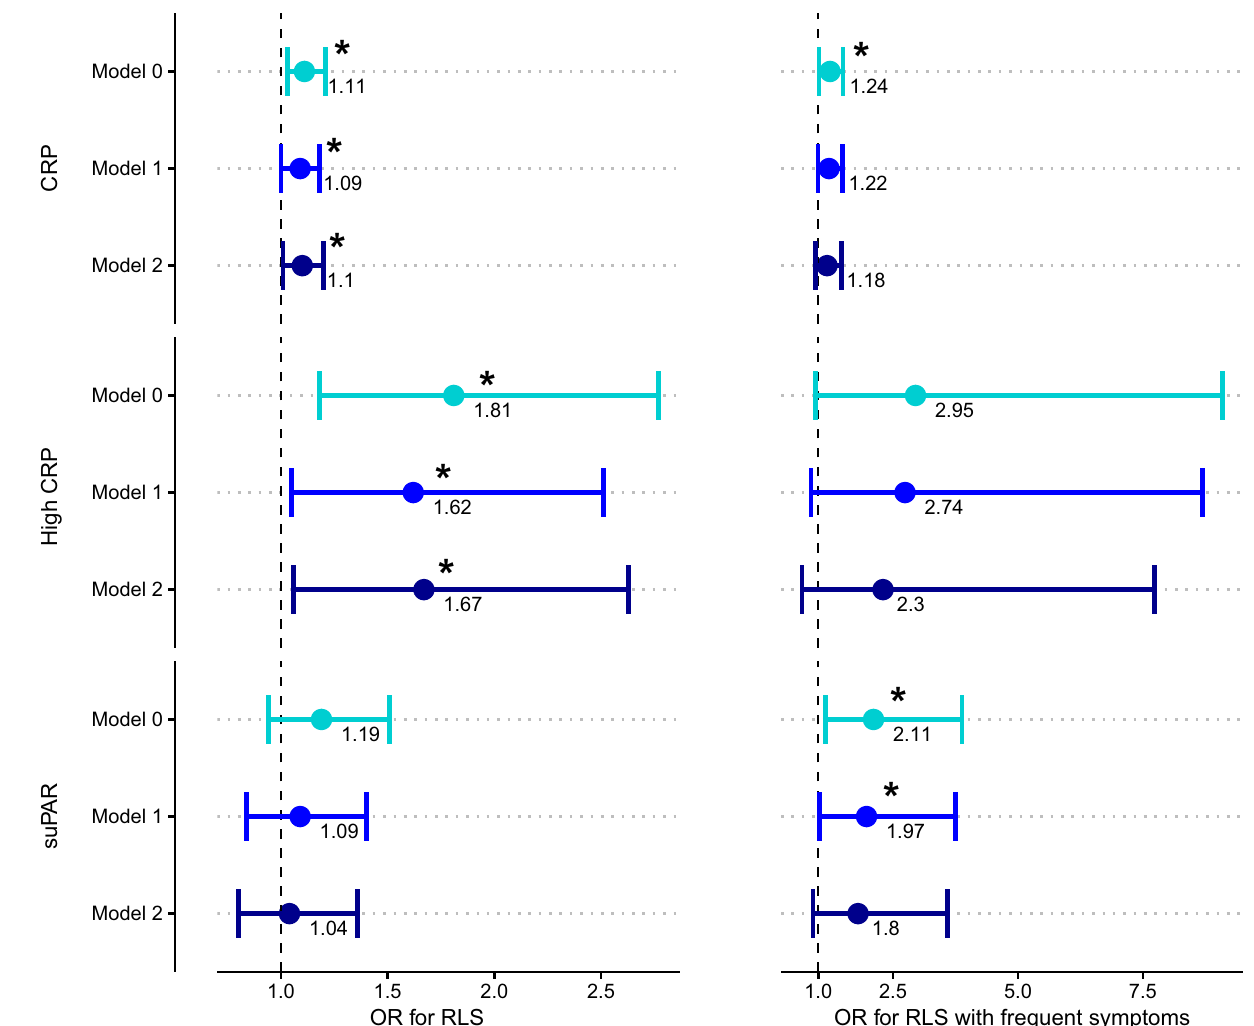
Figure 1. Chronic inflammation markers and association with RLS. Visualisation of the results from the logistic regression models using CRP levels (top row), CRP as a binary variable (middle row), and suPAR levels (bottom row) as the independent variable and RLS status (left column) or RLS with frequent symptoms (right column) as the dependent variable, using three different models. Model 0 = Crude association. Model 1 = adjusting for sex and age. Model 2 = adjusting for sex, age, smoking status and BMI. Data are presented as odds ratios (OR) with 95% confidence intervals, and an asterisk (*) denotes a P value < 0.05. OR = odds ratio. High CRP is classified as having CRP levels above 3 mg/L but below 10